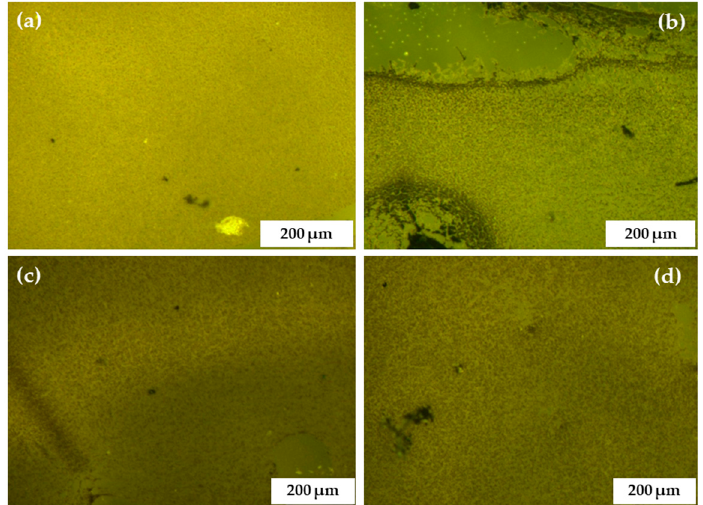
Figure 4. Light microscopic images of C-N-TiO 2 thin films recorded at calibration 90, at different speeds (2000 ( a ), 2300 ( b ), 2600 ( c ), to 2900 ( d ) rpm), and constant sol gel-solvent volume ratio of 3:5 for 90 sec. The samples were annealed in N 2 at 350 °C (ramping rate of 10 °C/min) for 105 min.